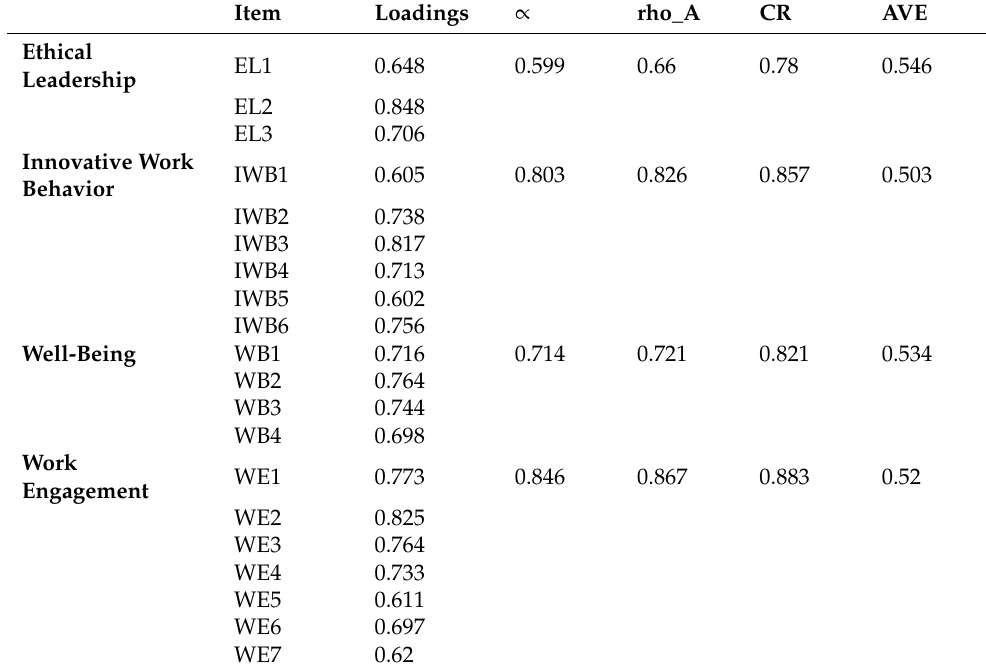
Table 2. Reliability and